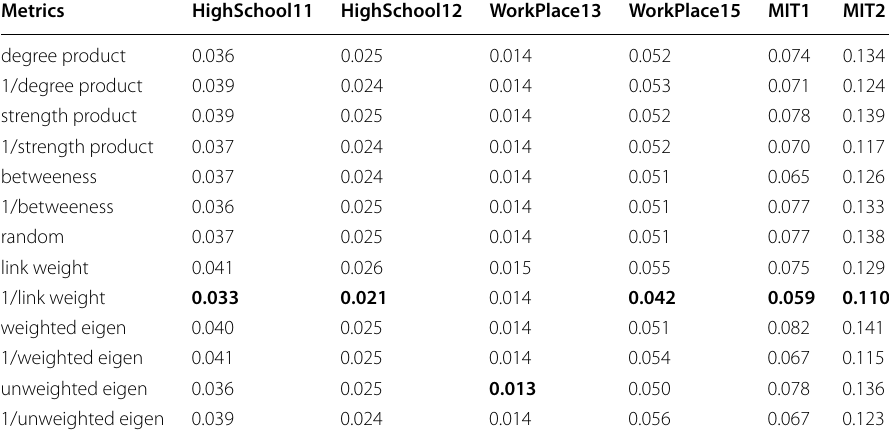
Table 9 The average prevalence E [ ρ ] when the recovery rate is γ = 1.22 ∗ 10 − 6 per step and φ = 10% of the contacts are removed from each temporal network using removal probability (3) based on each centrality metric and f ( t ) = 1 t ≤ T / 2 + 4 · 1 t > T / 2 . Contacts occurring late in time i.e. t > T / 2